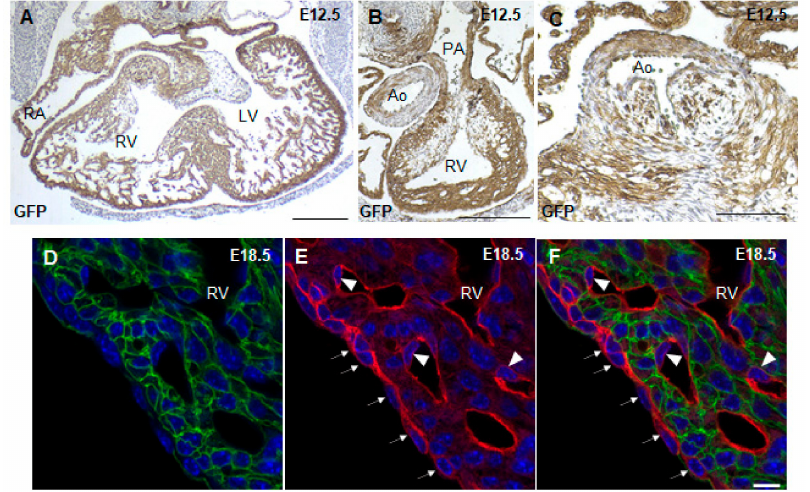
Figure 2. Lineage tracing with Nkx2.5-Cre;mT/mG mice. GFP immunostaining of E12.5 Nkx2.5- Cre;mT/mG paraffin heart sections showed Cre recombinase activity in the atrial and ventricular myocardium ( A ), OFT ( B ) and aortic valve leaflets ( C ). Fluorescence imaging of cryosections of E18.5 Nkx2.5-Cre;mT/mG hearts showed that the epicardium (arrows) and endothelial cells (arrowhead) remain RFP + in Nkx2.5-Cre;mT/mG hearts ( D – F ). RV, right ventricle; LV, left ventricle; PA, pulmonary artery; Ao, aorta; epi, epicardium. Scale bars: 250 µ m ( A – C ), 10 µ m ( D – F